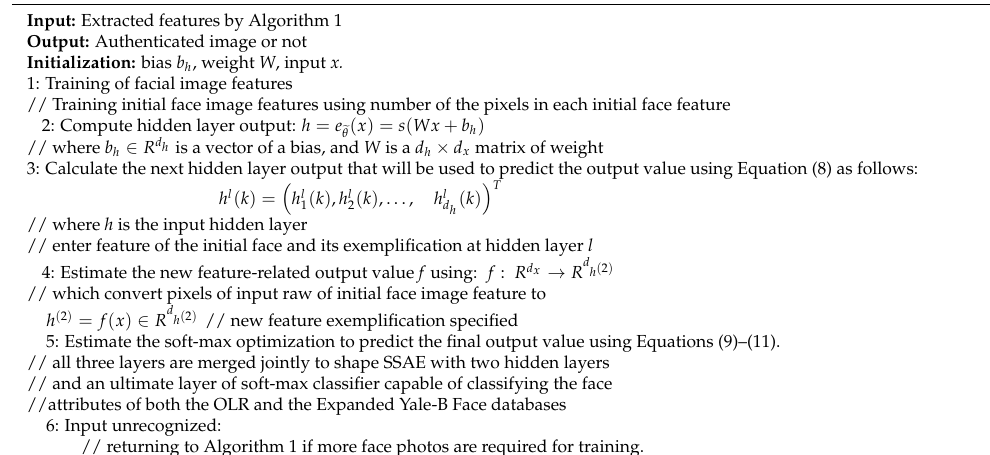
Algorithm 2: An algorithm for training stacked sparse autoencoder (SSAE) model with soft-max